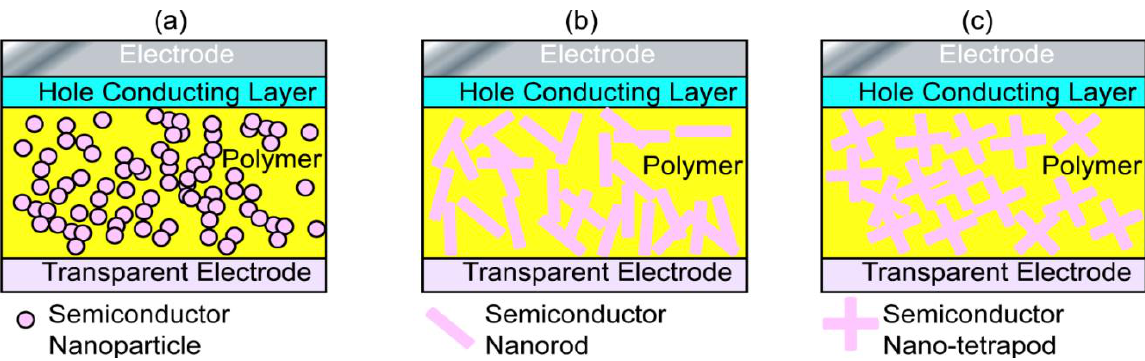
Figure 2. Various nano architectures of solar cell materials. ( a ) Blend of